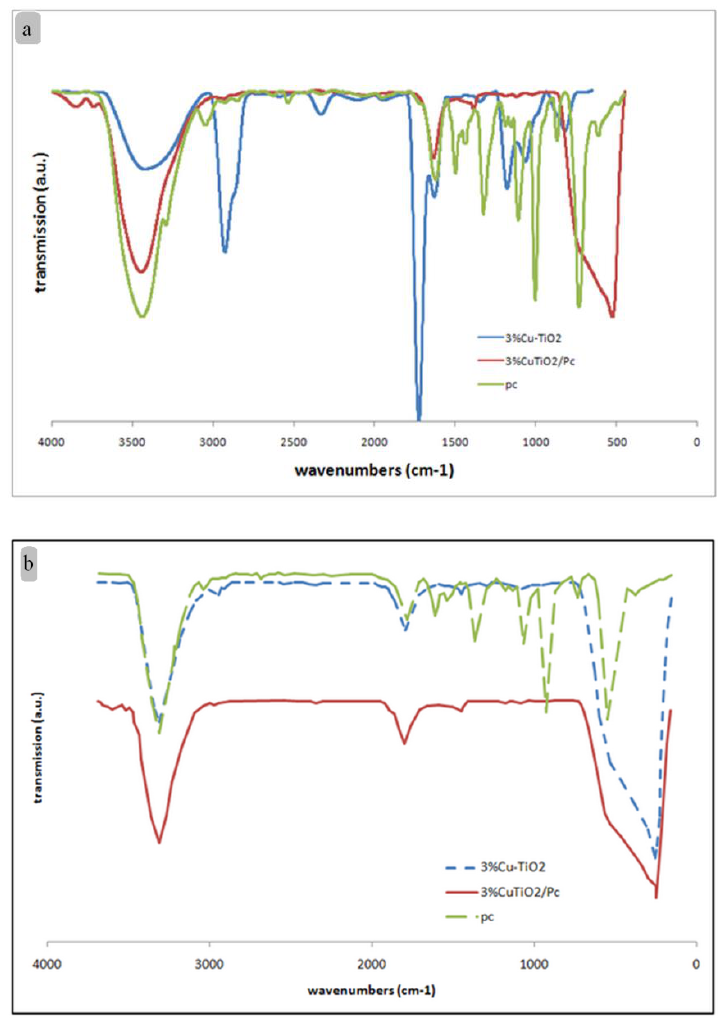
Fig. 5. IR results: (a) Cu-TiO , (b) Pc-Cu-TiO H-NC, and (c) pure 2 2 Figure 5. IR results: (a) Cu-TiO 2 , (b) Pc-Cu-TiO 2 H-NC, and (c) pure phthalocyanine.